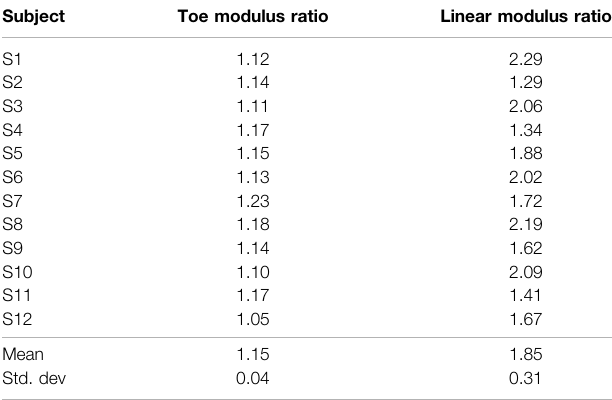
TABLE 2 | Shows the modulus ratio for toe and linear regions for each subjects.